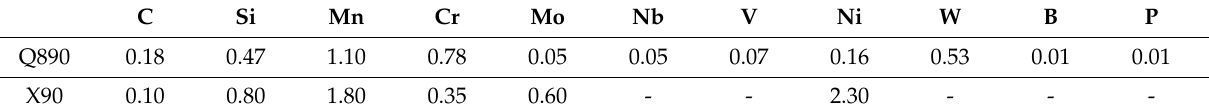
Table 1. Composition and content of chemical elements in HSLA Q890 and X90 filling wire (wt.%).